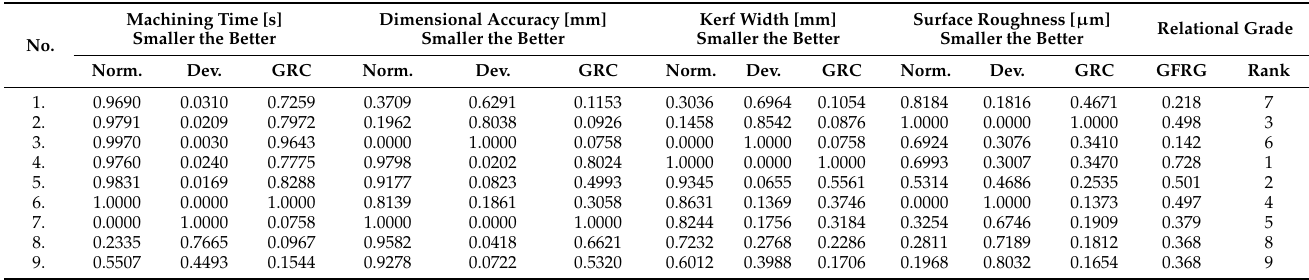
Table 5. Results of normalized values, deviation sequences, and grey relational coefficients.